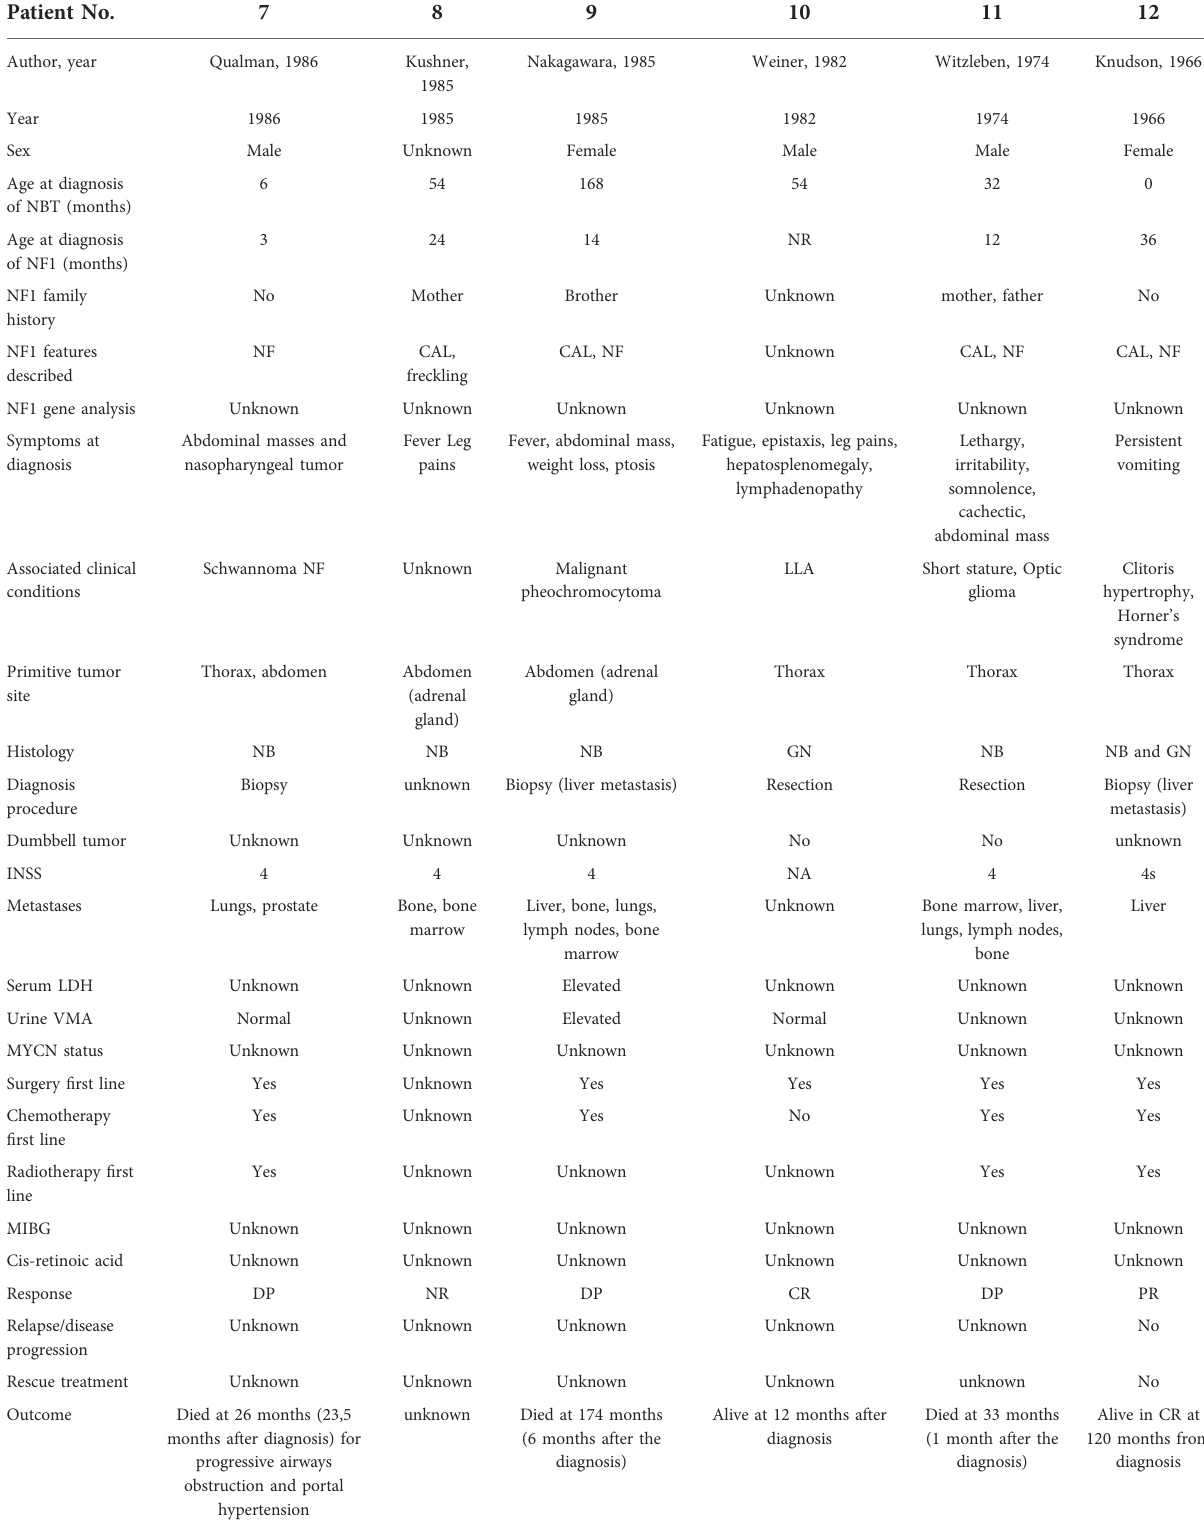
TABLE 6B Description of the cases reports analyzed by the literature (part 2). Patient